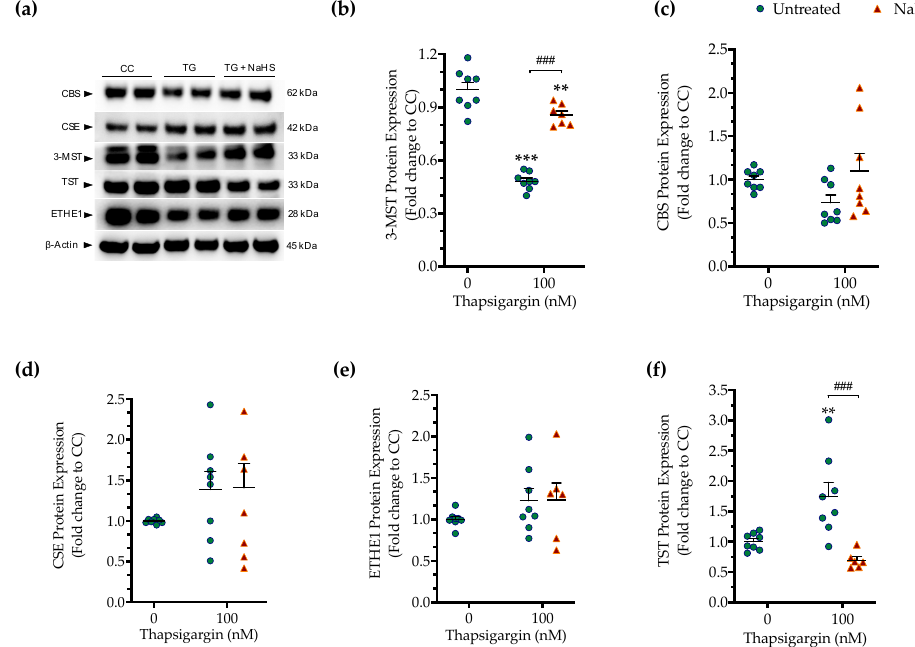
Figure 7. Hepatic persistent ER stress selectively down-regulates the expression of 3-MST enzyme for H 2 S synthesis; such an effect is reversible upon the exogenous donation of H 2 S . HepG2 cells were serum-starved for 8 h and treated with the vehicle or 100 nM of thapsigargin (TG), in the presence or absence of 100 µ M NaHS for 16 h. Subsequently, cells were harvested and the extracted protein was processed for Western blotting analysis of 3-MST ( a , b ), CBS ( a , c ), CSE ( a , d ), ETHE1 ( a , e ), and TST (rhodanese) ( a , f ) enzymes. Each graph line represents mean ± SEM from four independent experiments. Data are expressed as a fold change of the control (vehicle-treated) conditions (CC). ** p ≤ 0.01 and *** p ≤ 0.001 compared to CC; ### p ≤ 0.001 compared to the TG-treated cells. For abbreviations used, please refer to the main